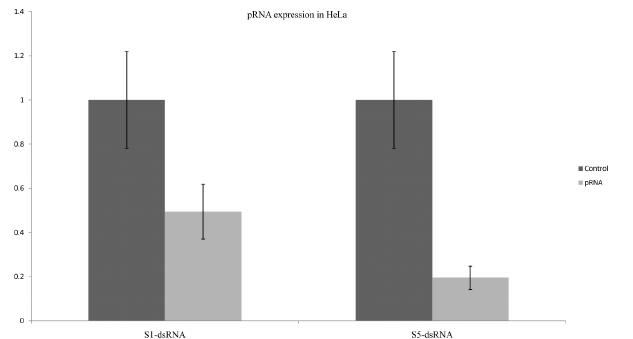
pRNA specific primers. S1 and S5 transfection showed significant (p < 0.01) decrease in pRNA expression. Expression ratio was calculated with respect to 18S, POLR2A, PPIA and β -actin by REST software. pRNA: